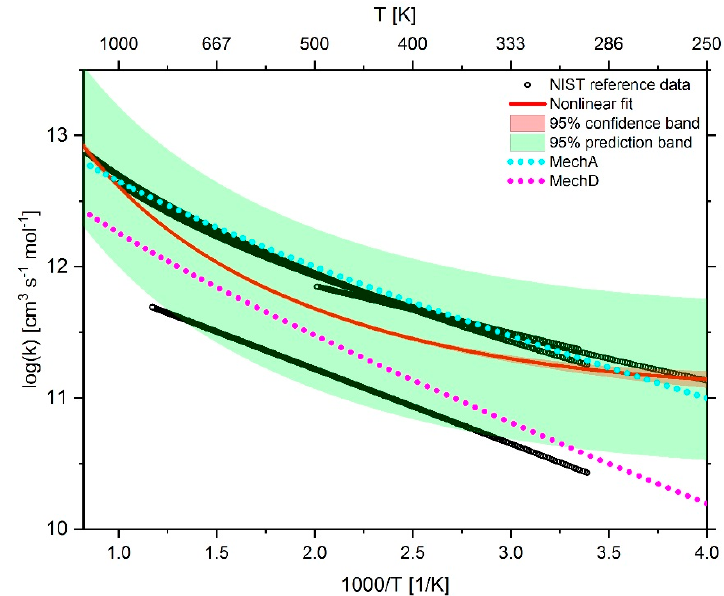
Figure 12. Comparison of the reaction rate coefficient of reaction 235 (C 3 H 8 + OH ↔ n -C 3 H 7 + H 2 O) of MechA and MechD as well as the fitted rate coefficient using reference data from the NIST database.